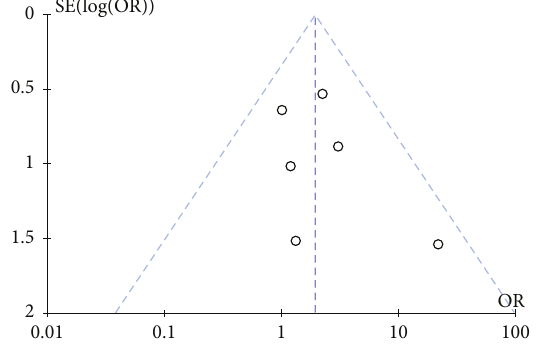
Figure 3: Funnel plot for publication bias regarding overall response